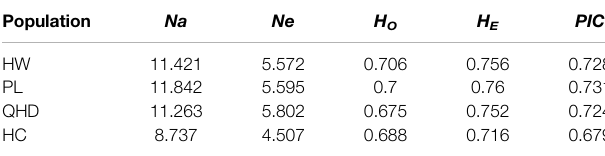
TABLE 4 | Mean genetic parameters of four P. trituberculatus populations.